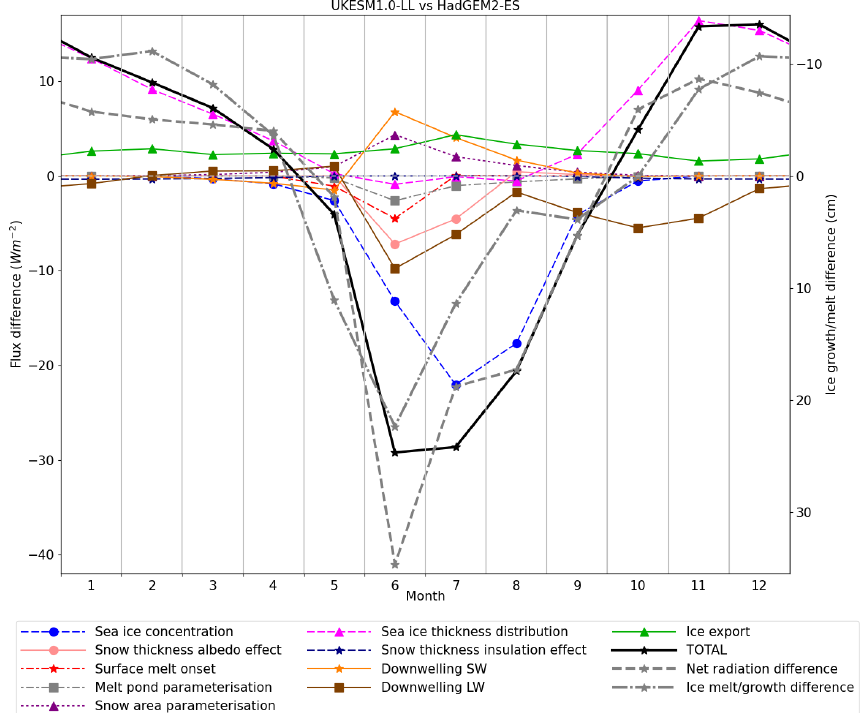
Figure 8. ISF differences compared between pairs of models over the year as a whole for UKESM1.0-LL relative to HadGEM2-ES. Averages are taken over the 1980–1999 period and the Arctic Ocean region. The grey lines show, for comparison, the total net radiation difference and the ice growth and melt difference. All values are plotted in watts per square metre (Wm − 2 ; left axis), while the right axis shows the equivalent monthly ice growth and melt difference in centimetres, assuming an ice density of 917kgm − 3 and latent heat of fusion 3 . 35 × 10 5 Jkg − 1